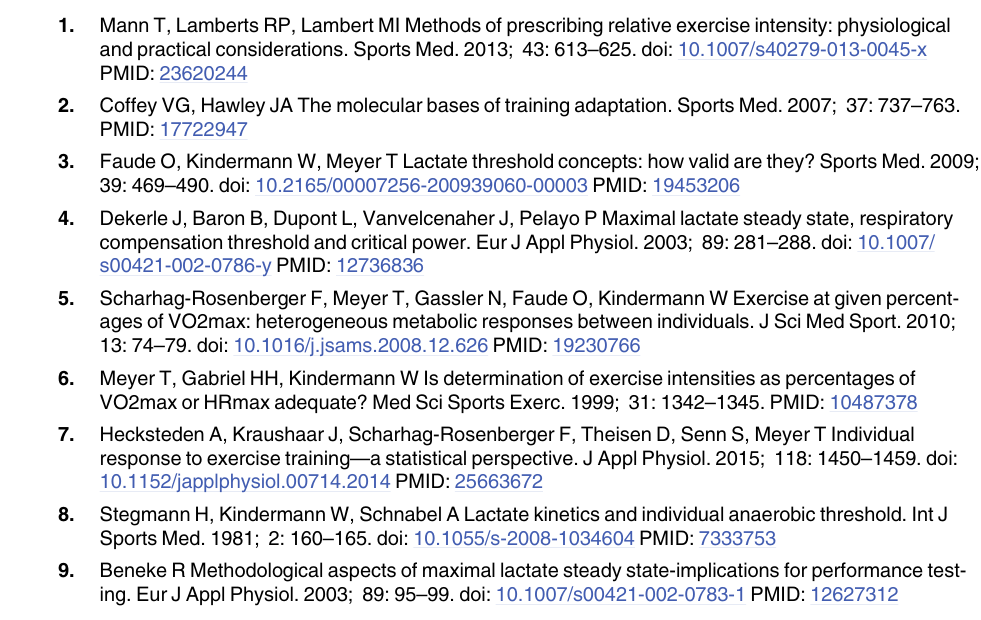
S1 Protocol. Trial study protocol approved by the local ethics committee (translated ver-